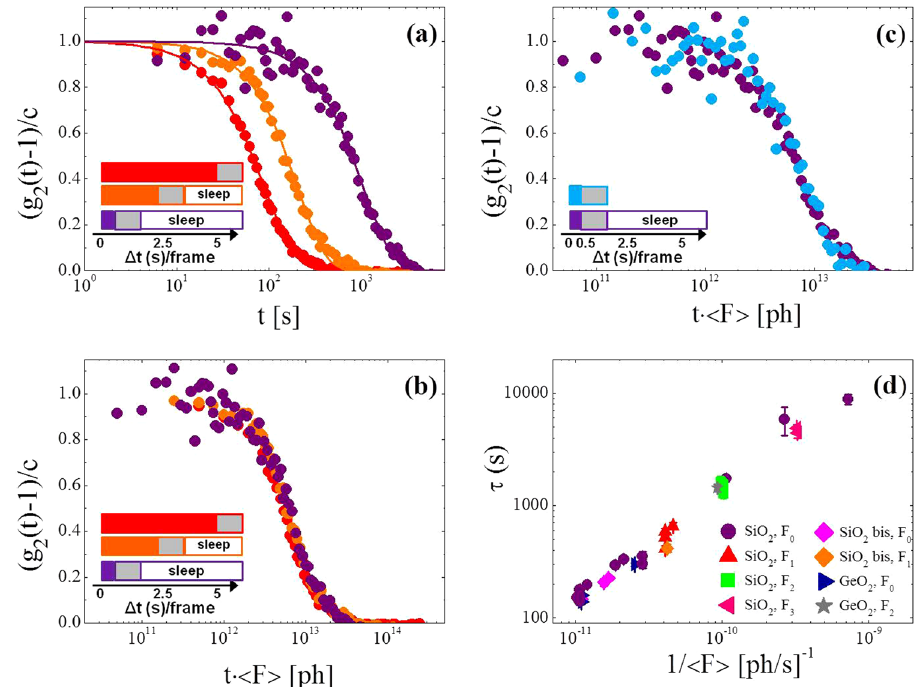
Figure 2. Tuning of the atomic motion. ( a ) Normalized intensity auto-correlation functions measured in vitreous silica at T = 295 K and Q p = 1.5 Å − 1 with fixed lagtime per frame, Δ t = 6.15 s, but with different sleeping times Δ t s and exposure times Δ t e . From left to right: Δ t e = 5 s and Δ t s = 0 s (red), Δ t e = 2.5 s and Δ t s = 2.5 s (orange), Δ t e = 0.5 s and Δ t s = 4.5 s (purple). The legend illustrates the acquisition mode per frame with full coloured boxes for the exposure times Δ t e (beam on), empty boxes both for the sleeping times Δ t s (beam off) and the constant readout time of the CCD Δ t r (beam off, grey boxes). ( b ) Same data as in panel (a) but now normalized by the mean flux < F > = F 0· Δ t e / Δ t. ( c ) (g 2 (t) − 1)/c measured with Δ t e = 0.5 s and Δ t s = 4.5 s (same purple data as in panel (a) reported as a function of the time t times the mean flux. The data are compared with the g 2 (t) measured with the same exposure time Δ t e = 0.5 s and no sleeping time ( Δ t s = 0 s, cyan). ( d ) Decay time for different combinations of the incident flux and the lagtime. The data are shown as a function of the inverse mean flux. Also included is data for a second SiO 2 sample (SiO 2 bis) and for vitreous GeO 2 . The legend indicates the flux used for each set of measurements.